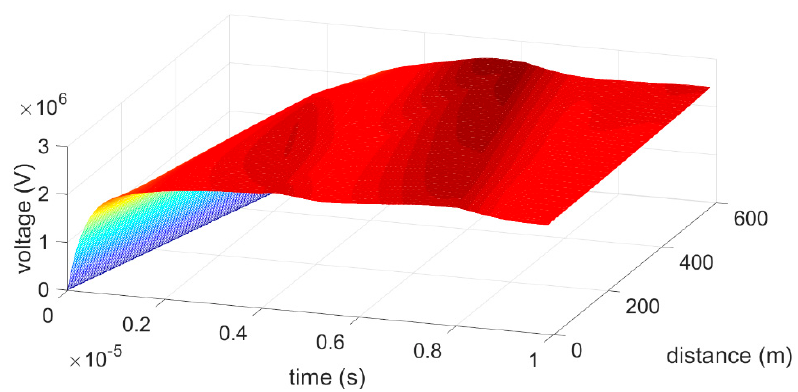
Figure 13. Computed transient voltage profile along phase A when there were no surge arresters connected at the receiving end of the line (example 3.3).